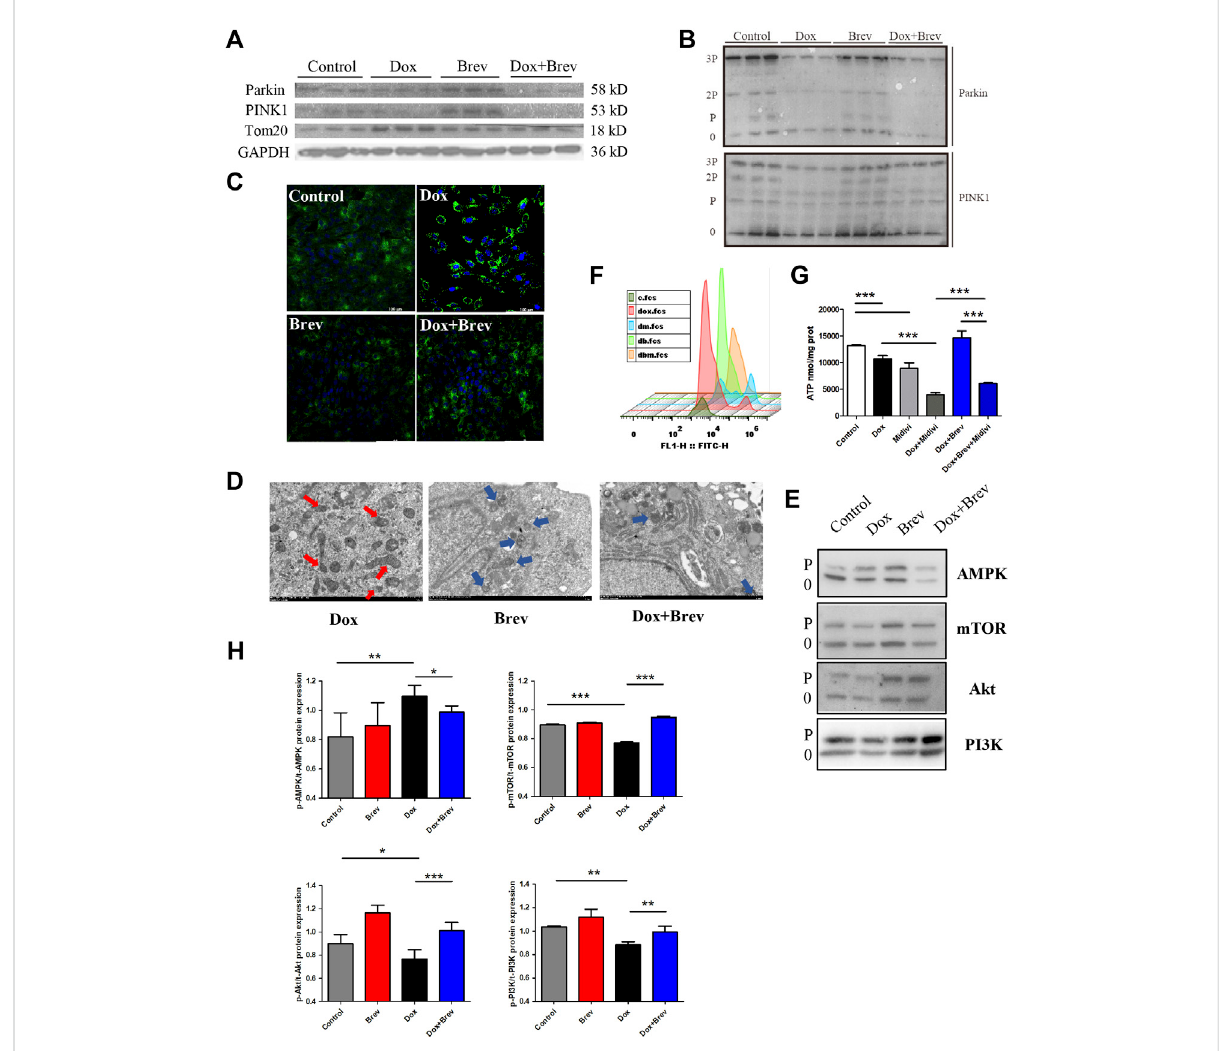
FIGURE 6 (A) Expression levels of PINK1, Parkin, Tom20, and GAPDH were measured in vitro by WB. (B) The expression levels of p-PINK1, p-Parkin, and Tom20 were assessed. (C) Mitotracer staining. (D) Electron microscopy. (E) The expression levels of p-AMPK, p-mTOR, p-Akt, and p-PI3K were evaluated. (F) The intensity of ROS staining in H9c2 cells after supplementation with Mdivi-1. (G) ATP content in H9c2 cells after